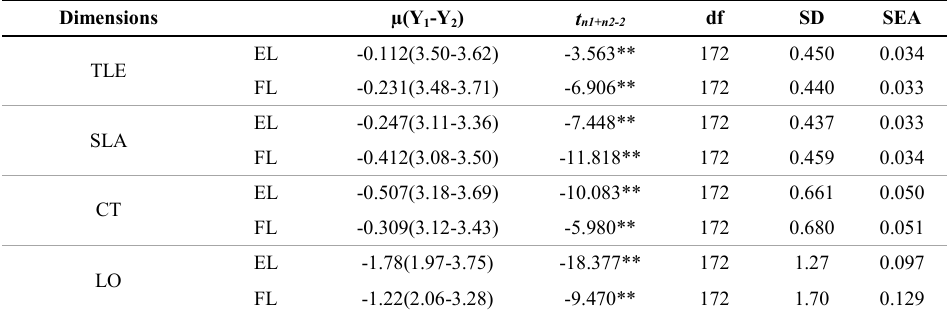
Table 3. Study of the value of independence between dependent samples between the control group and experimental group. T for Student for related